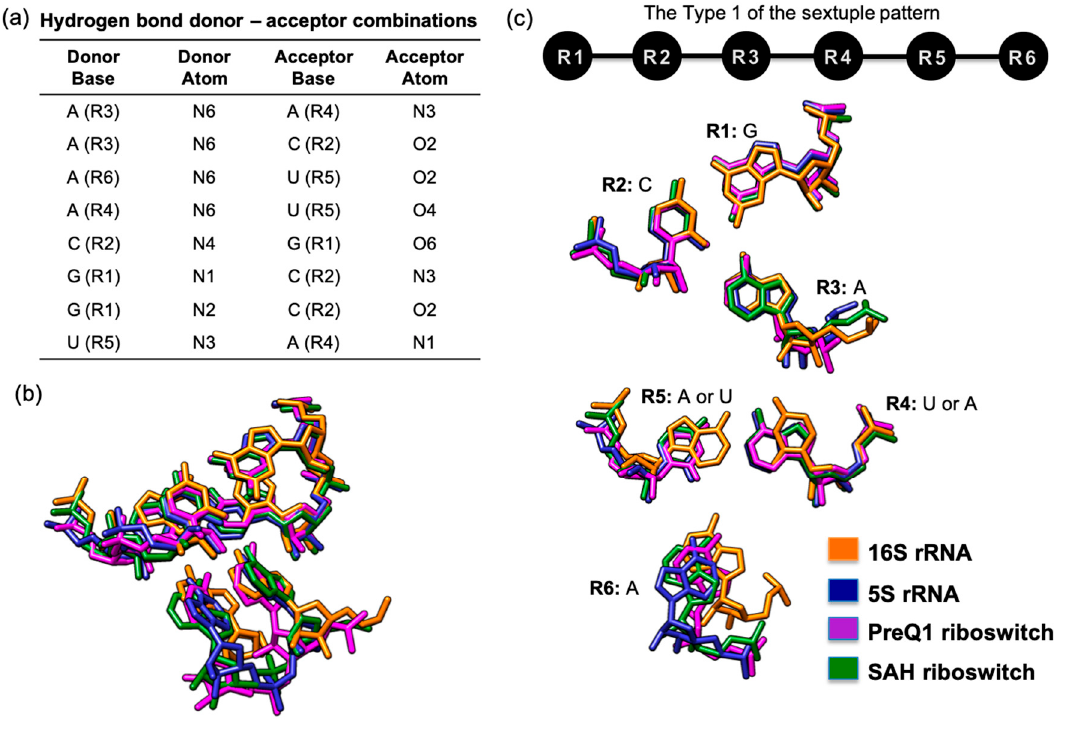
Figure 3. An example of a GCA(A/U)(U/A)A 3D arrangement that was annotated in four different RNA crystal structures. (a) Table of hydrogen bond donors and acceptors that define the hydrogen-bonded base network; (b) superposition of four similar base arrangements showing how they can be viewed in the four different RNA crystal structures; (c) graphical representation of the hydrogen bond network for the type 1 sextuple pattern (top) and corresponding base-by-base view of the superposed bases in the four different RNA crystal structures (bottom).